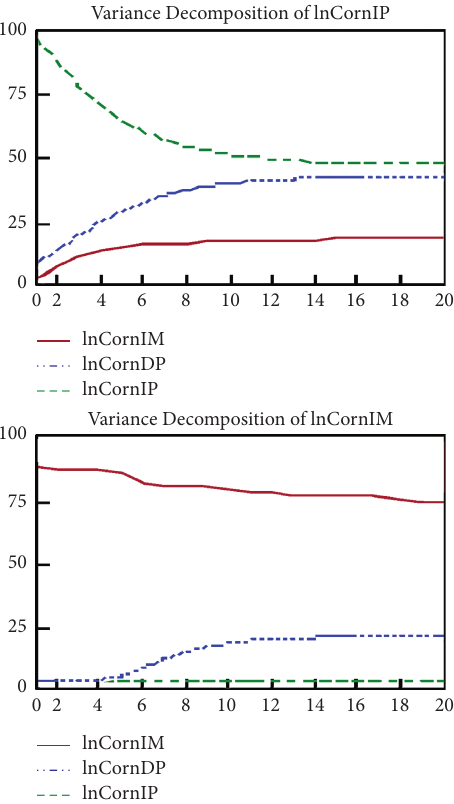
Figure 11: Variance decomposition analysis results for